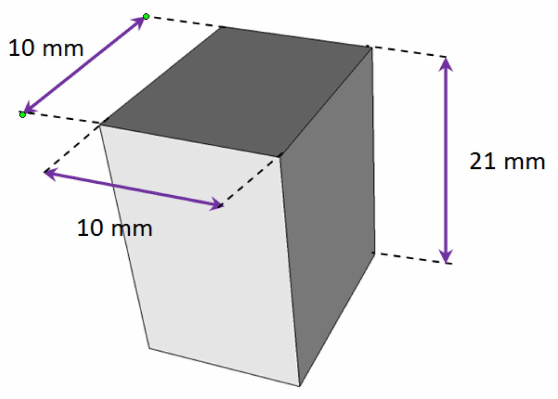
Figure 26. Elementary magnet size, such a high level of segmentation is due to the main frequency of the magnetic flux fluctuation which implies a geometry where dimensions must not be greater than the skin depth (here, 23